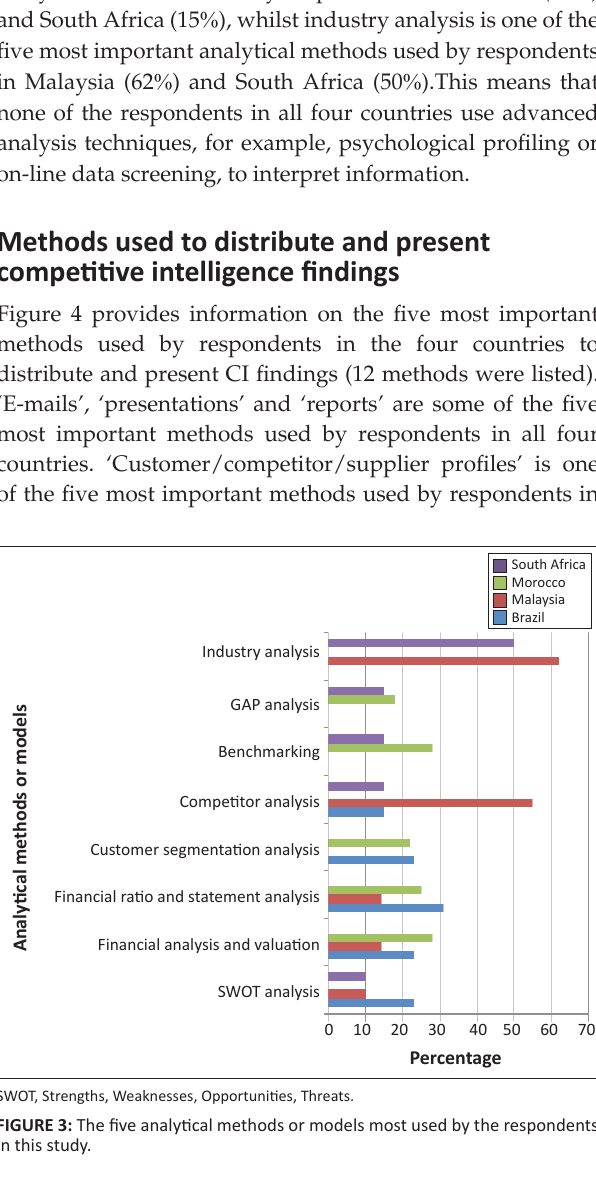
TABLE 2: The five most important primary sources used by the respondents in this study. Primary source